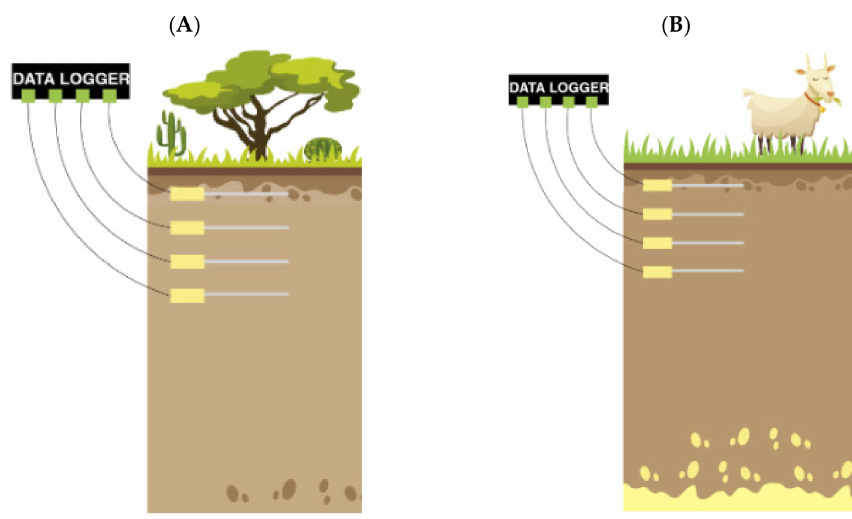
Figure 2. Soil moisture monitoring schemes, such as TDR, at BR-CST ( A ) and BR-GST ( B ) towers. In this work, the cubic regression was used to adjust the soil moisture to pulse the sensors’ time. Figure 3 shows the adjustment with the cubic model for both sites.